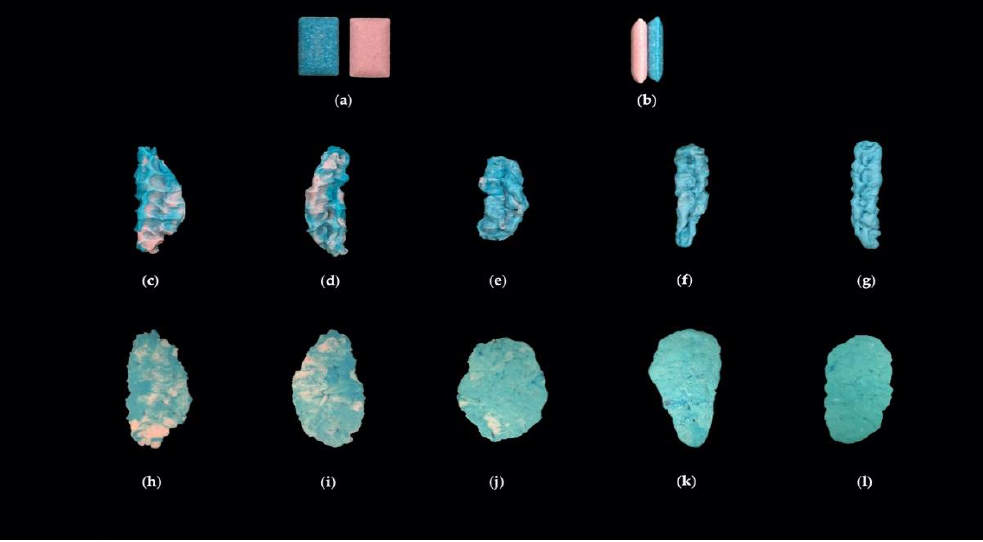
Figure 1. Chewing gum specimens: ( a ) the two colored chewing gums; ( b ) the two colored chewing gums stuck together; ( c – g ) chewing gum boluses after 5, 10, 20, 30, and 50 masticatory cycles, respectively; ( h – l ) flattened chewing gum boluses after 5, 10, 20, 30, and 50 masticatory cycles, respectively.